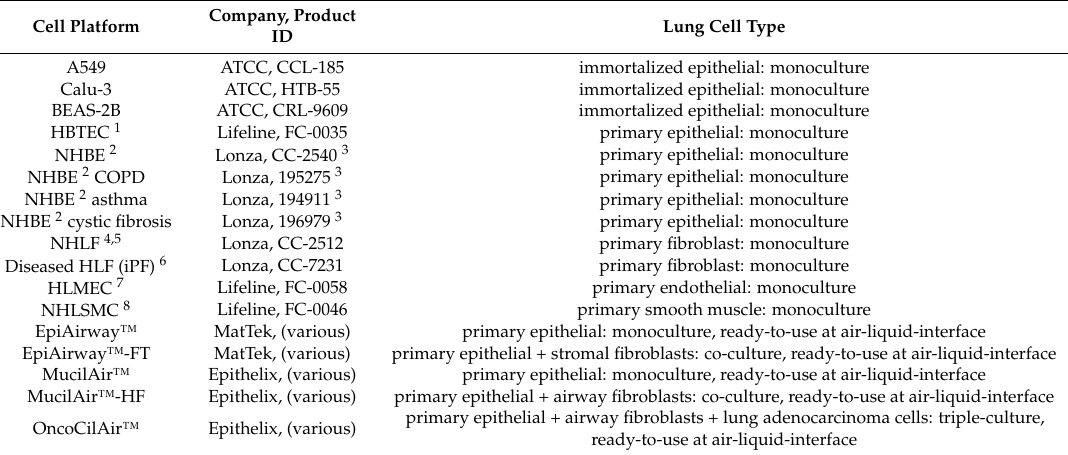
Table 1. Commercially relevant primary lung monocultures and co-culture lung cell